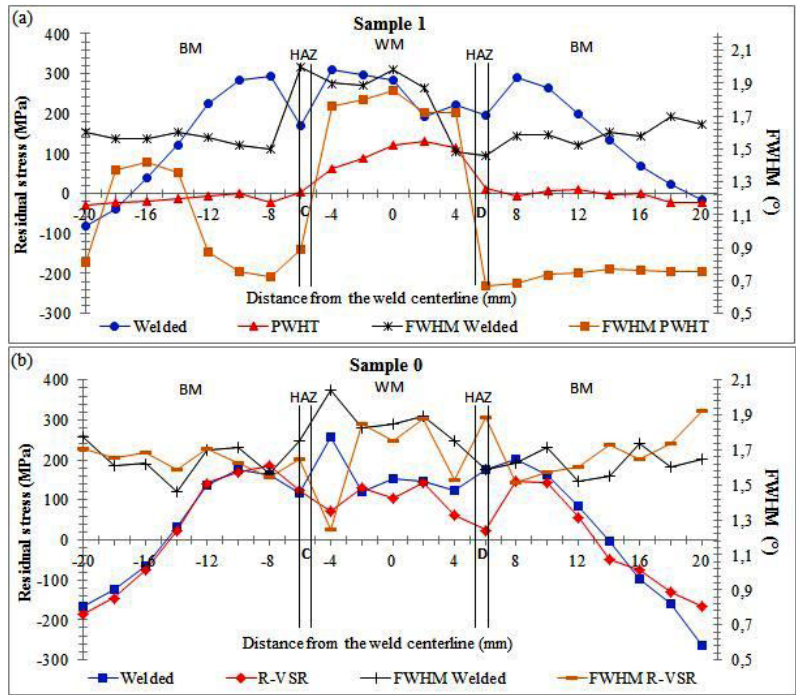
Figure 8. (a) Comparison between FWHM and transverse residual stresses measured in the sample 1. (b) Comparison between FWHM and transverse residual stresses measured in the sample 0. Solid lines indicate the extent of the weld bead and